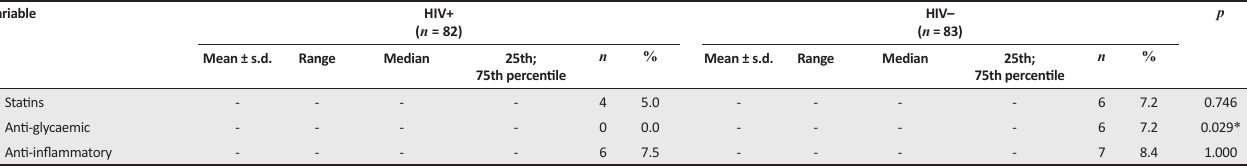
TABLE 1-A1 (Continues...): Characteristics of PLWH and without HIV, stratified by age tertile groups. Variable